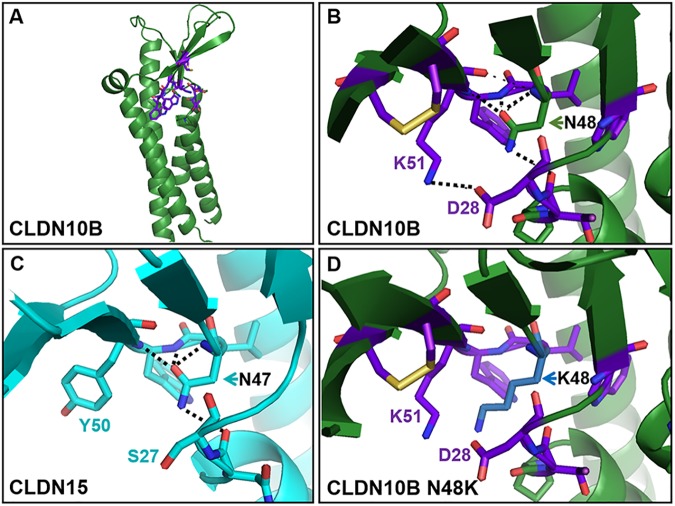
Homology modeling predicts structural alterations of claudin-10b p.N48K.(A) Homology model of the tertiary structure of claudin-10b based on crystal structure of murine claudin-15 (PBD ID: 47P9) as template. Backbone is shown as cartoon in green and residues of the claudin consensus motif (W-G/NLW-C-C), T27, D28 and K51 are shown as sticks in violet. (B) Region of claudin-10b model around N48 (green stick) in detail highlighting likely electrostatic interactions (dotted lines) between N48 and backbone of surrounding residues (T27, L49, W50) as well as potential electrostatic interaction between residues K51 and D28. (C) In the claudin-15 structure (cyan), the corresponding residue N47 participates in similar interactions (dotted lines) whereas residues Y50 (corresponding to K51) and S27 (corresponding to D28) do not interact. (D) The p.N48K substitution (blue) prevents the interactions mediated by N48 and may also disturb a D28-K51 interaction. O atoms, red; N atoms, dark blue; S yellow.